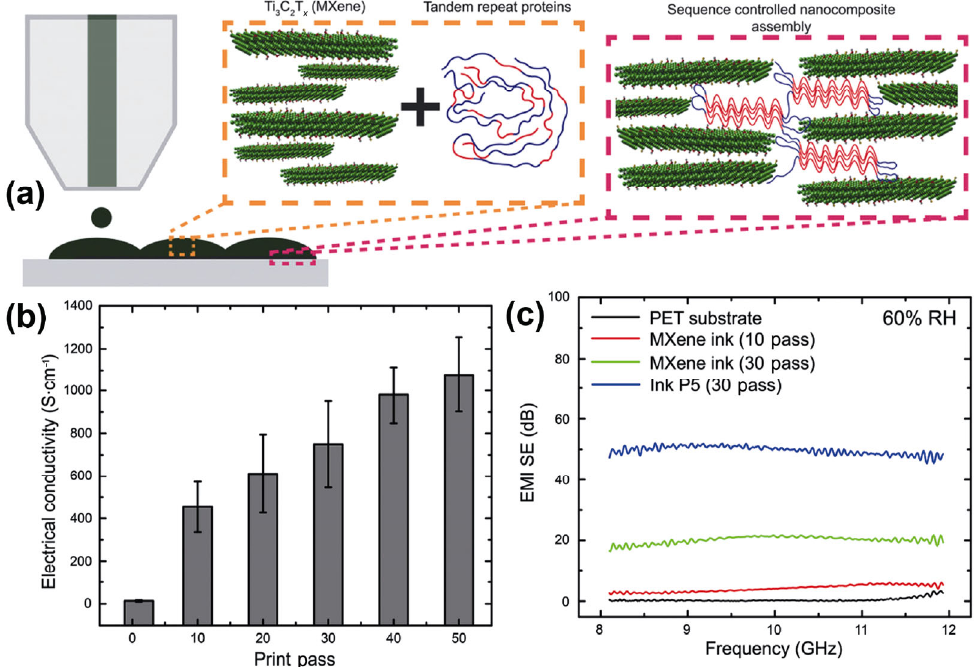
Fig. 29 (a) Illustration of protein-mediated assembly of MXene sheets during inkjet printing. (b) Electrical conductivity of large area electrodes inkjet-printed on PET. (c) EMI SE of large area (circle, φ = 2 cm) electrodes inkjet-printed on PET using various ink solutions (MXene ink, ink P5) at dry condition (60% relative humidity). Reproduced with permission from